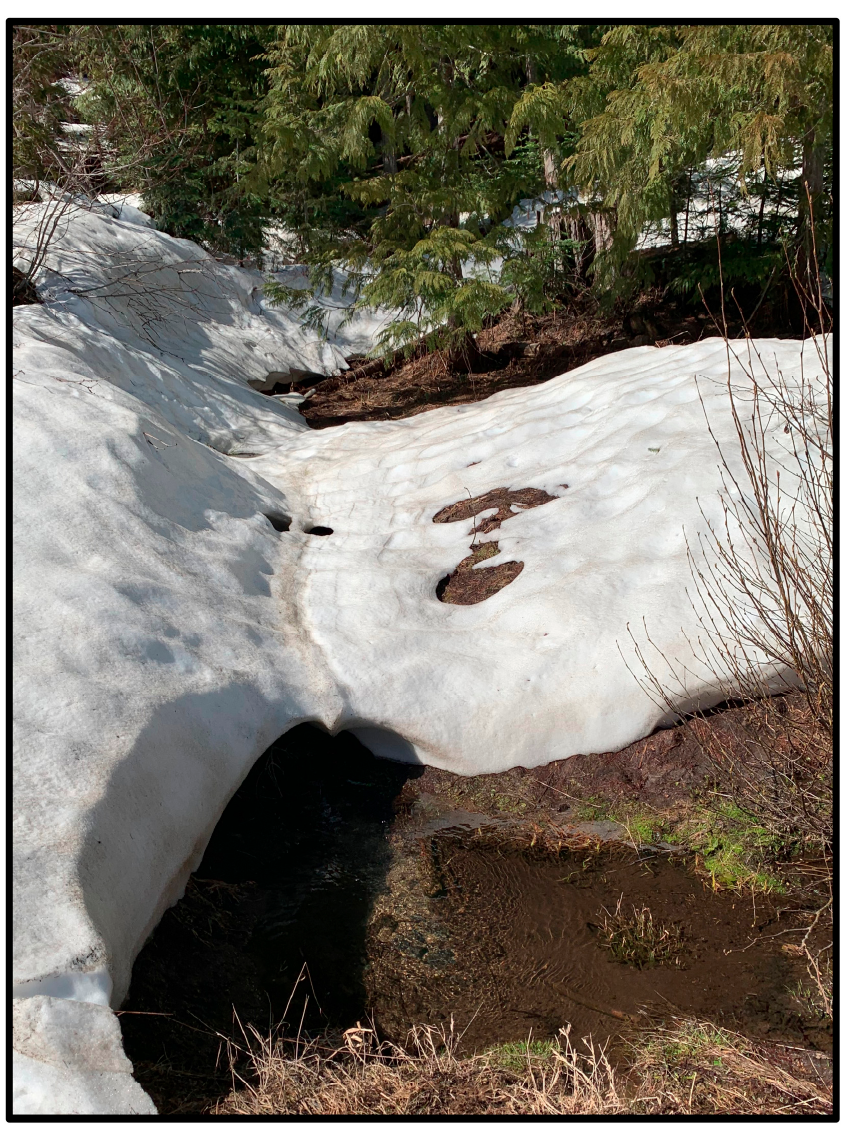
Figure 9. Example of snowmelt runoff in an ephemeral creek in the Palouse Range during spring 2020. In the foreground is a small pond that fills then drains into a subsequent channel.